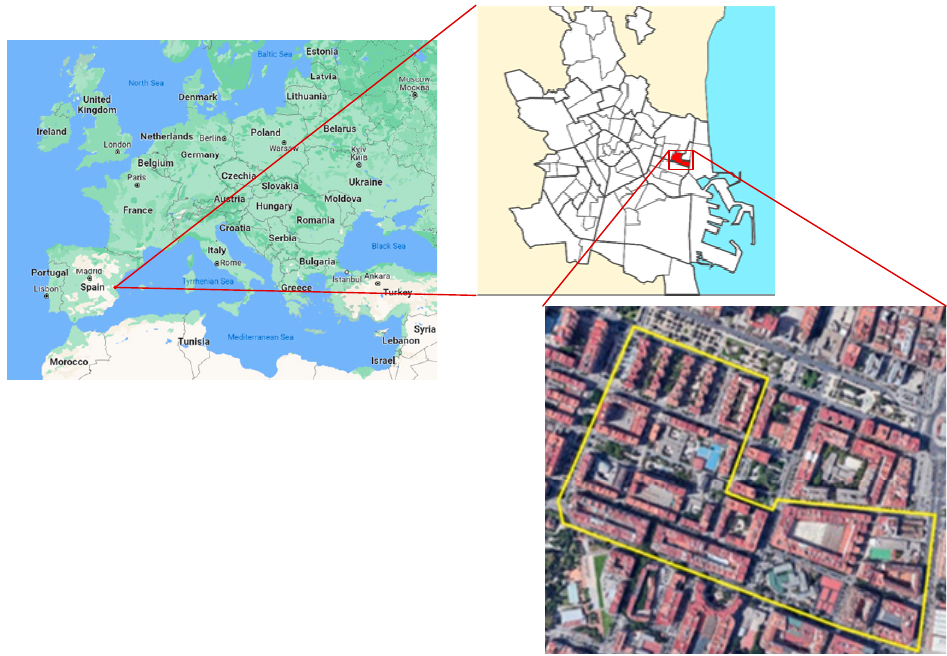
Figure 1. Position of L’Illa Perduda in Valencia. Map taken from Google Maps.